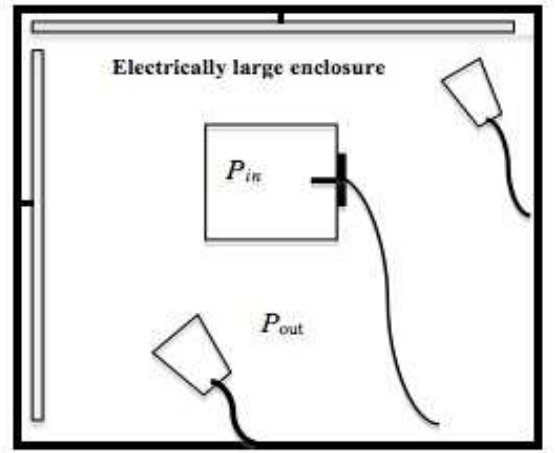
Figure 1: Illustration of the RC set-up measurements From power balance it can be written